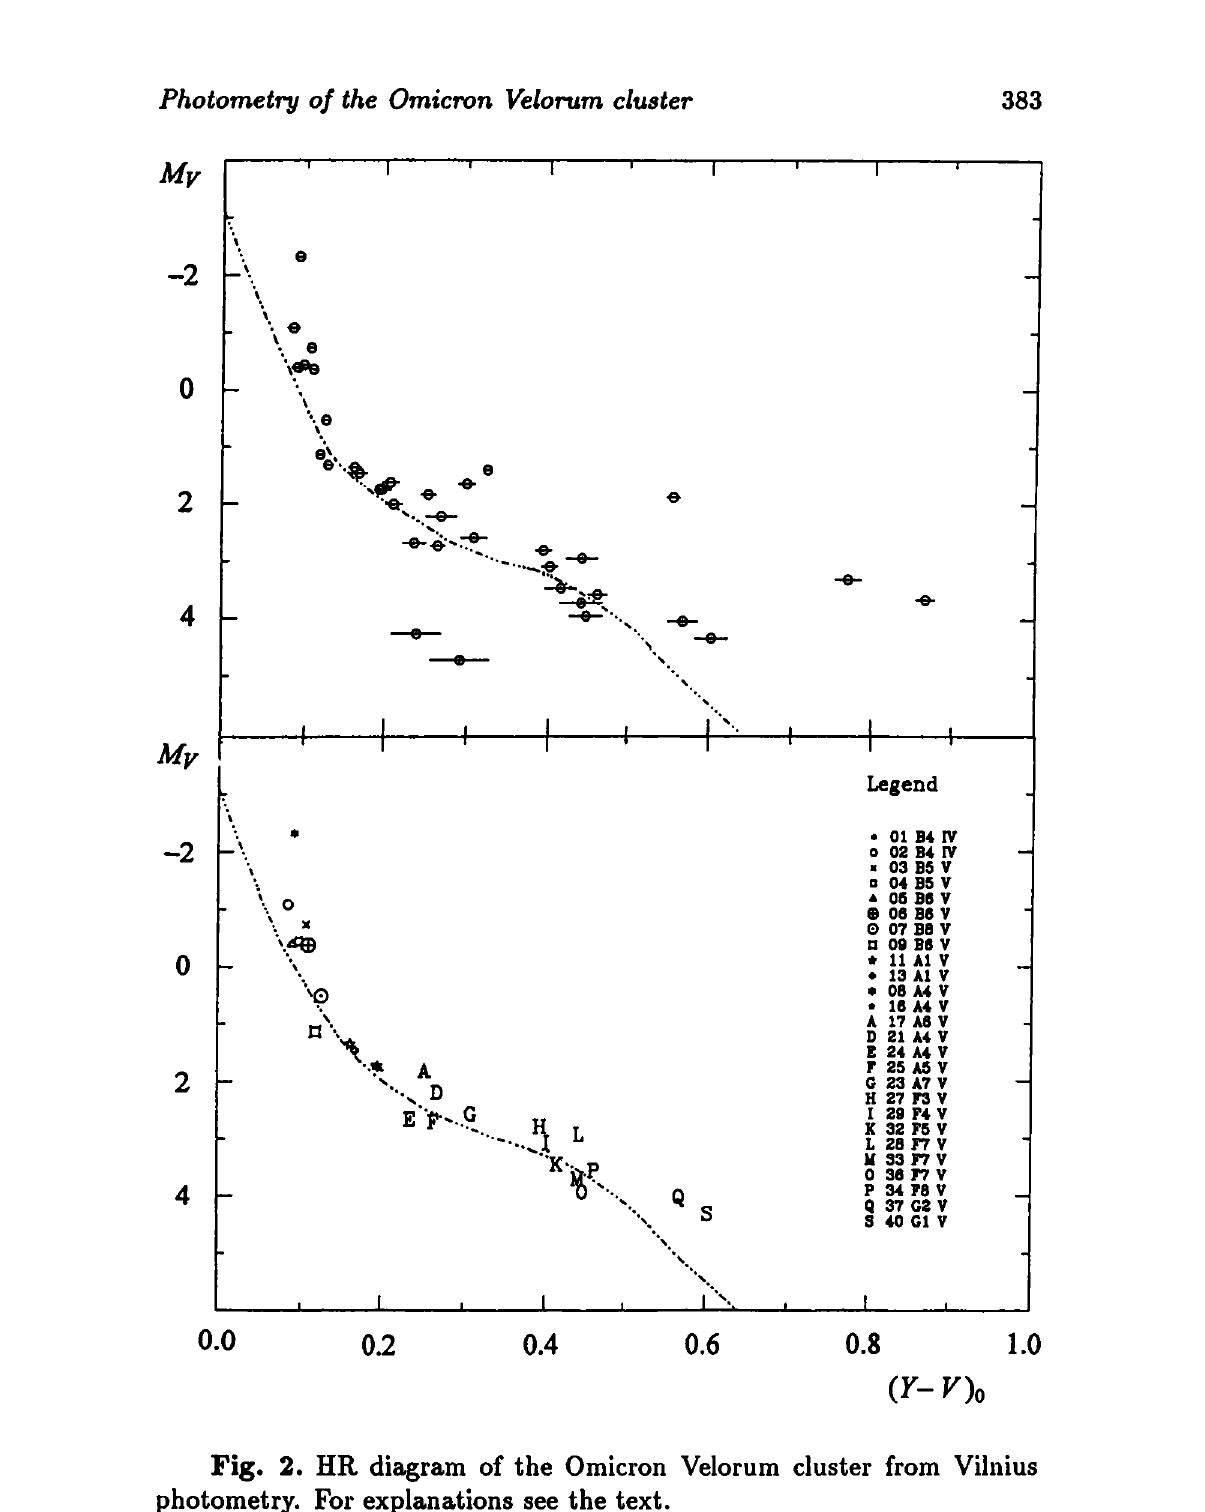
Fig. 2. HR diagram of the Omicron Velorum cluster from Vilnius photometry. For explanations see the